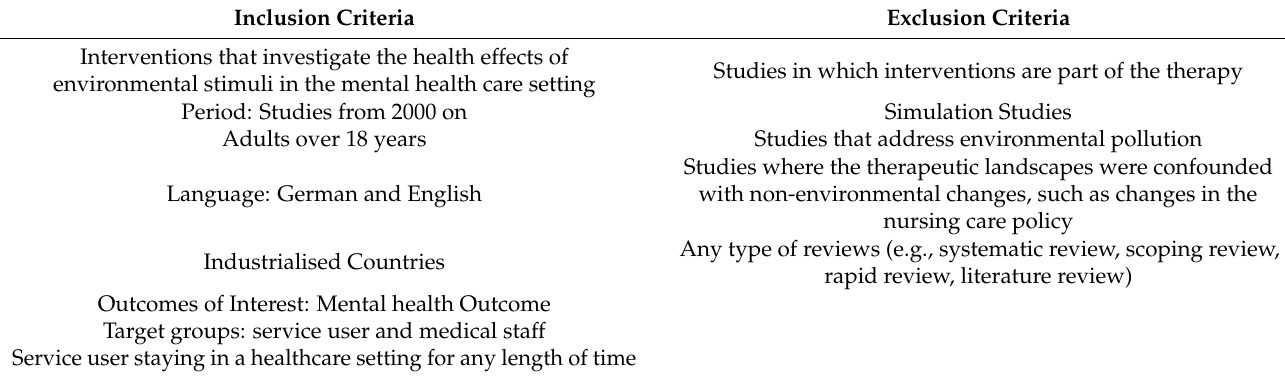
Table 2. Inclusion and exclusion